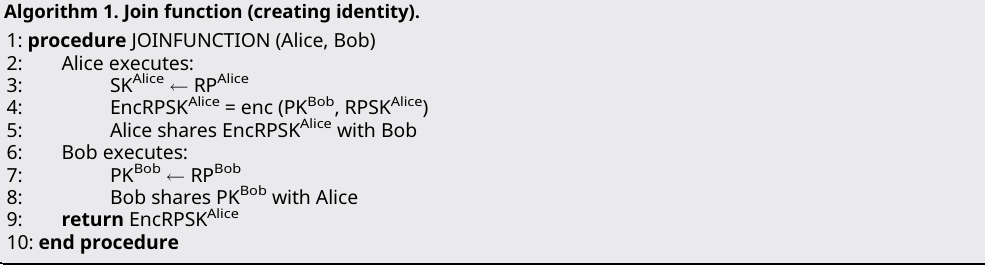
Algorithm 1. Join function (creating identity).